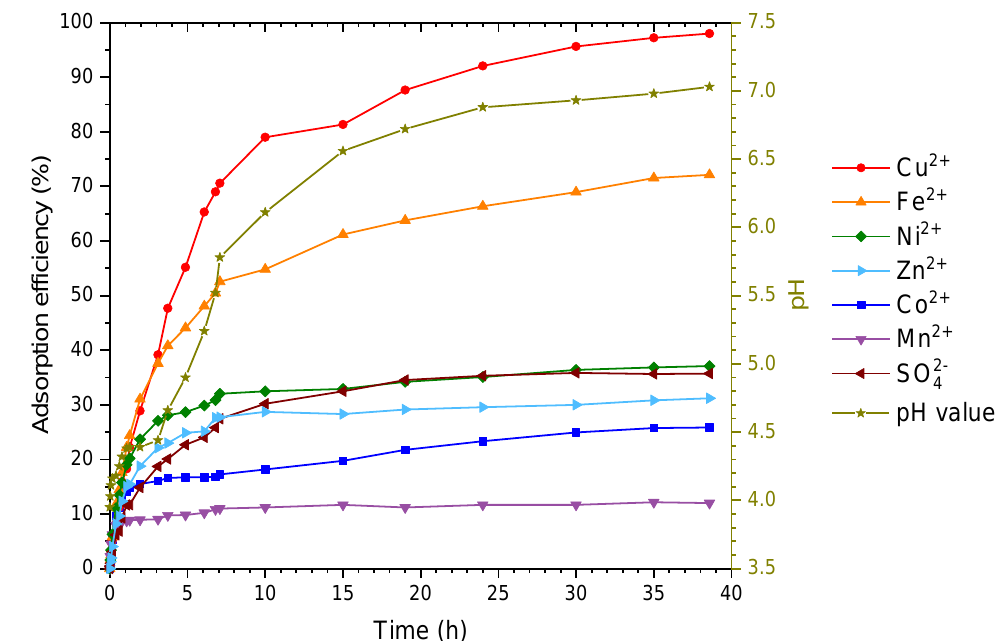
Figure 6. Column experiment with all six heavy metal sulfate salts. The column was filled with the chitosan flakes and the concentration of the heavy metal ions and sulfate was measured as a function of time, including the change in pH. The initial concentrations of each heavy metal ion in the solution was c 0 (Mn 2+ ) = 4.06 mmol·L −1 ; c 0 (Fe 2+ ) = 4.05 mmol·L −1 ; c 0 (Co 2+ ) = 4.08 mmol·L −1 ; c 0 (Ni 2+ ) = 3.91 mmol·L −1 ; c 0 (Cu 2+ ) = 3.97 mmol·L −1 ; c 0 (Zn 2+ ) = 3.93 mmol·L −1 ; and c 0 (SO 42− ) = 28.64 mmol·L −1 . Graph was also plotted as c(t)/c(0) vs. time (see Figure S38 ) and q(t) vs. time (see Figure S39 ).